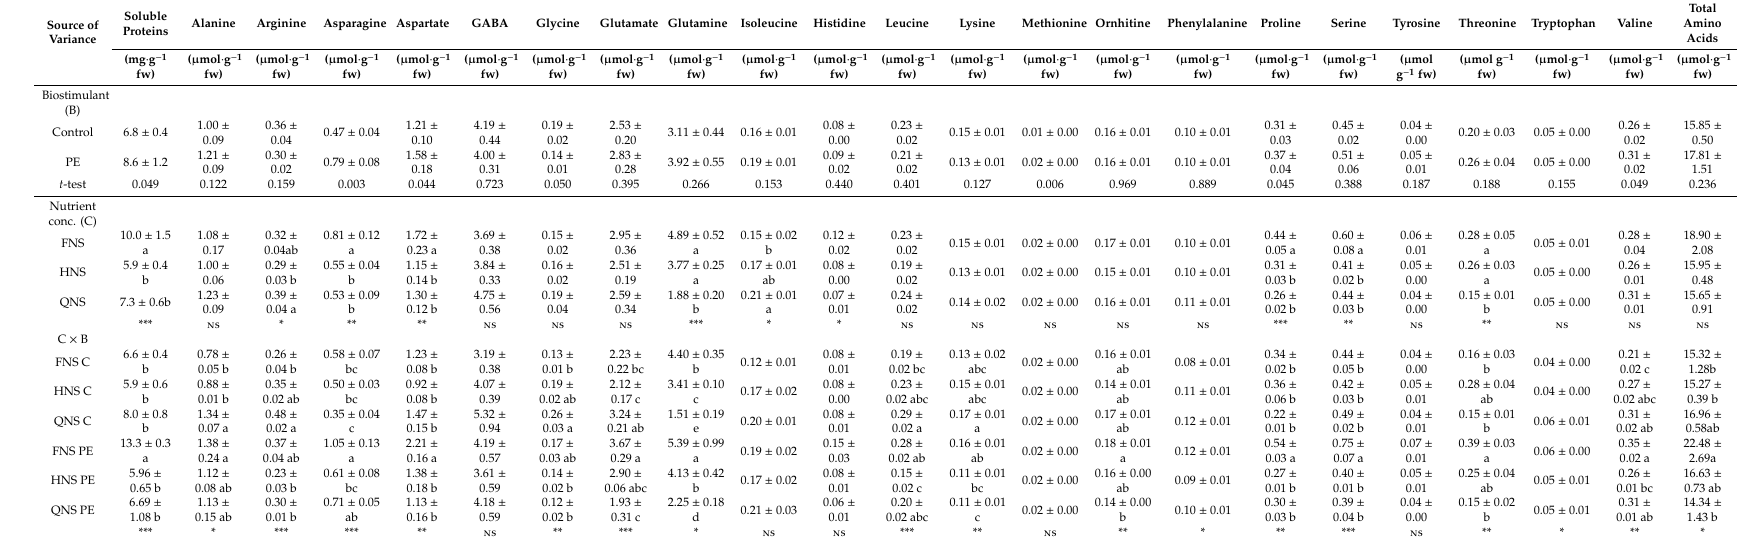
Table 5. Soluble proteins, free amino acids profile and total amino acids content in leaves of hydroponically grown jute in relation to nutrient solution concentration and tropical plant extract biostimulant application. All data are expressed as mean ± error, n =